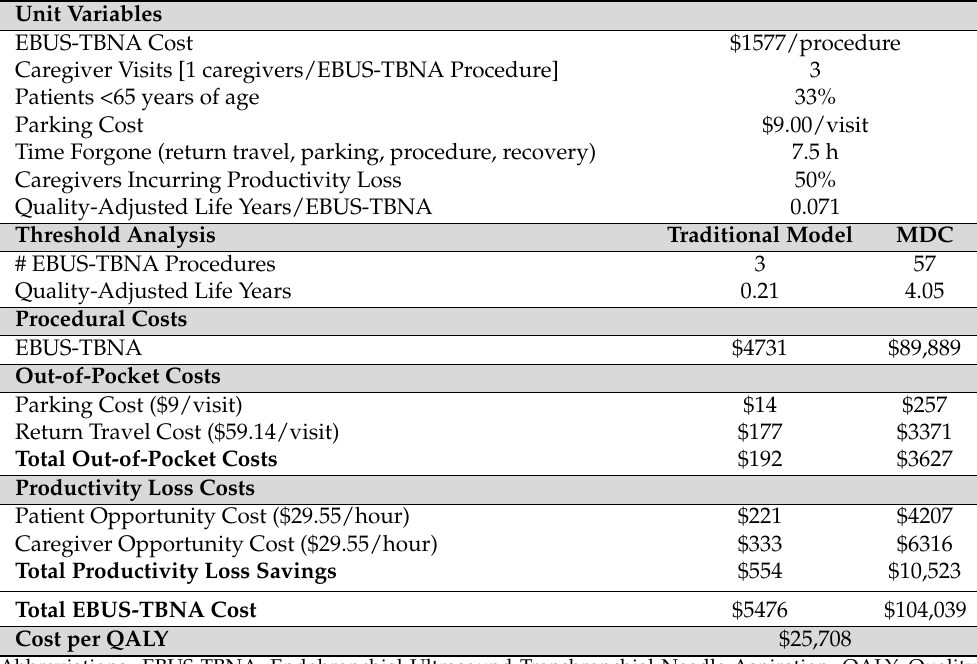
Table 4. Threshold analysis for invasive mediastinal staging by